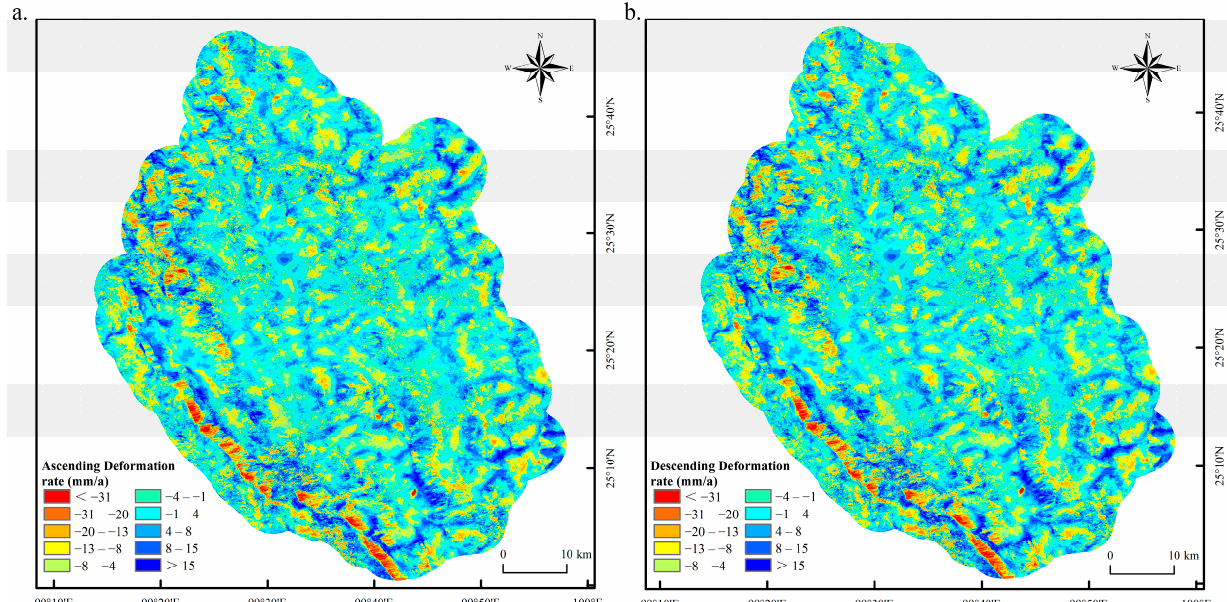
9 of 16 Figure 3. Landslide formation factors: ( a ) lithology, ( b ) distance from fault, ( c ) rainfall, ( d ) NDVI, ( e ) distance from road, ( f ) distance from river, ( g ) elevation, ( h ) aspect, ( i ) slope, ( j ) curvature, ( k ) plane curvature, ( l ) profile curvature, ( m ) surface roughness, ( n ) terrain relief, ( o ) Topographic Wet- ness Index. 4. Results and Discussion 4.1. InSAR Deformation Treatment Results In order to facilitate the processing, we made a 5 km buffer for Yongping County, and the related deformation processing results are shown in Figure 4, and the samples selected based on this are shown in Figure 5. As shown in Figure 4a and Table 2, the mon- itoring data of ground surface deformation in Yongping County is normally distributed as a whole (the values of skewness and kurtosis passed the statistical test, as shown in Table 3), and the deformation rate in most areas is between − 8 and 8 mm/a, covering an area of 2215.59 km 2 and accounting for 79.42% of the total area. The area with a defor- mation rate of − 20~ − 8 mm/a is 264.5 km 2 , accounting for 9.48% of the total area. The area of < − 31 mm/a is only 7.14 km 2 , accounting for 0.26% of the total area. The area with a deformation rate of 8~15 mm/a is 226.95 km 2 , accounting for 8.14% of the total area. The